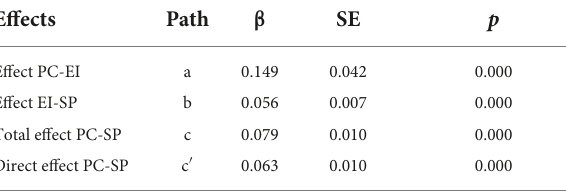
TABLE 3 Testing the mediation effect of expression inhibition on social